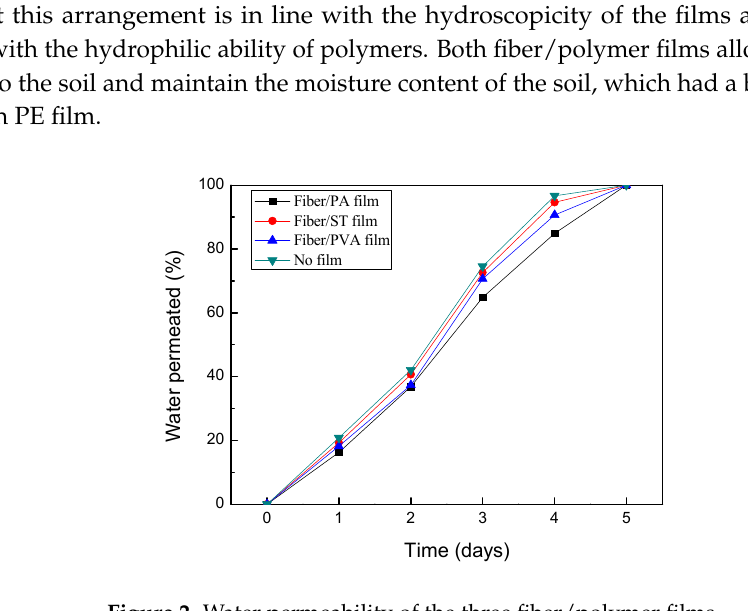
Figure 2. Water permeability of the three fiber/polymer films.